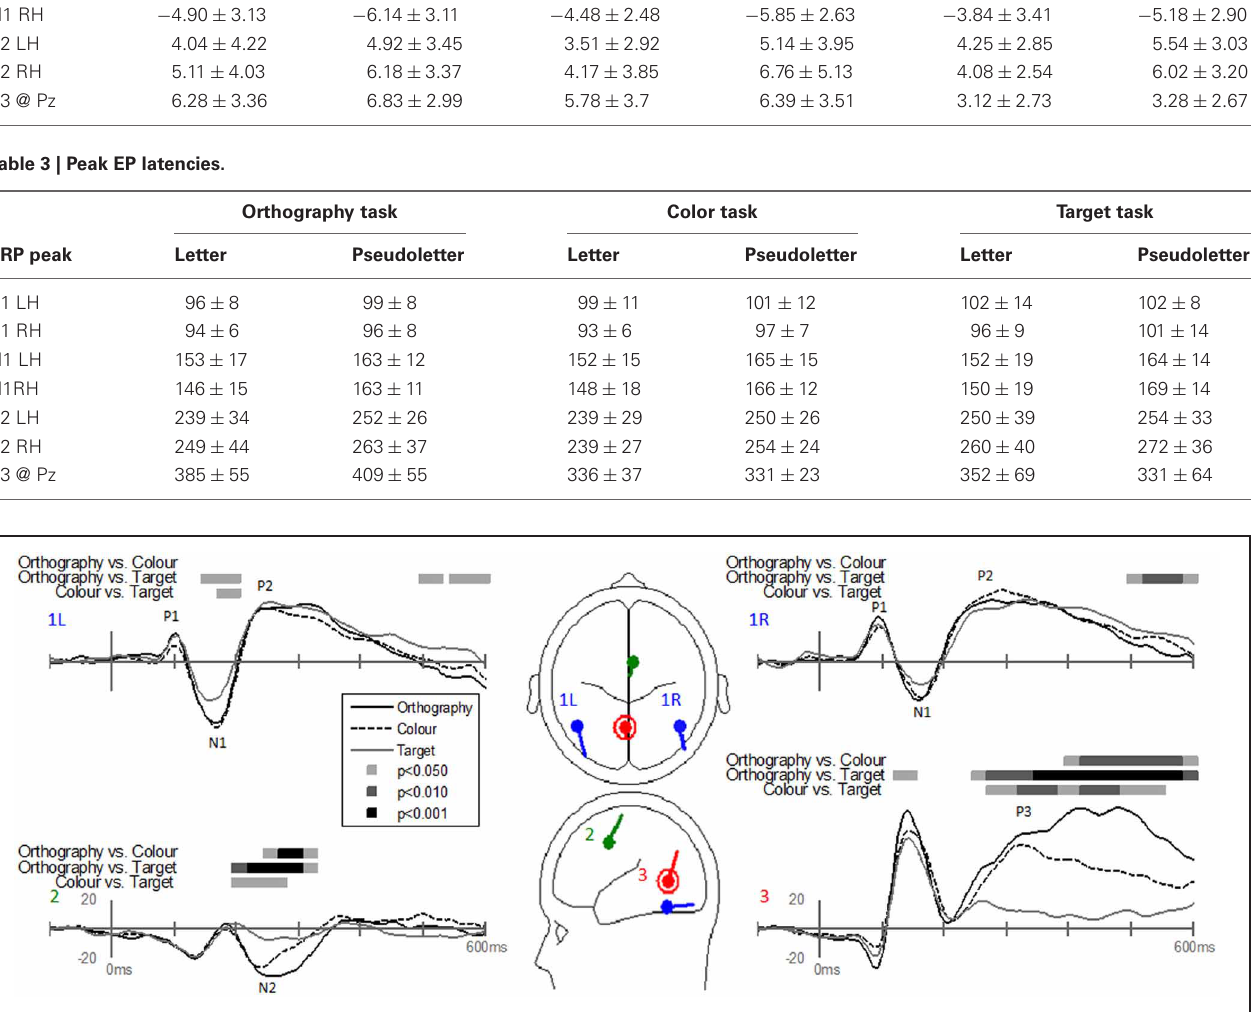
FIGURE 6 | Grand-mean source waveforms for Task effects averaged across stimulus type (letters and pseudoletters) for the Task-effects model (inset) with bilateral dipoles in the fusiform gyri (dipoles 1L and 1R), medial frontal gyrus (dipole 2), and